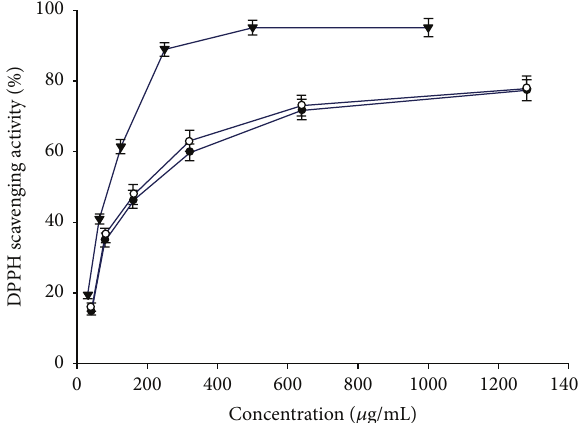
Figure 2: DPPH radical scavenging activity of fixed oil of Annona muricata L. seeds extracted using hexane ( e ), ether ( I ), and Vit. E ( 󳶃